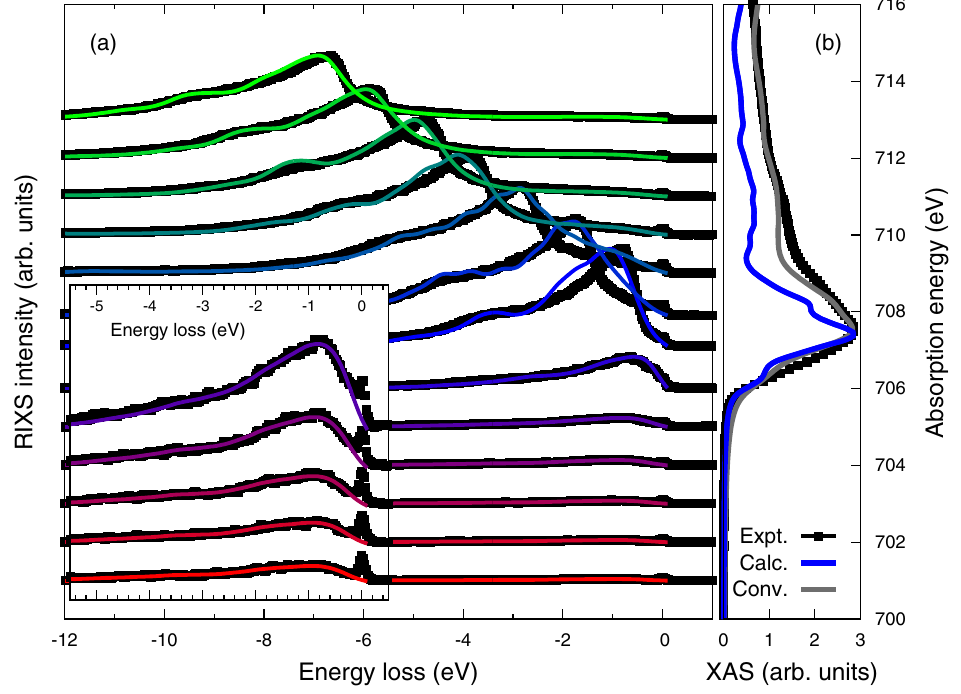
FIG. 4. (a) RIXS spectra at the Fe L 3 edge of BaFe 2 As 2 plotted versus energy loss comparing BSE evaluation of the Kramers- Heisenberg equation (colored curves) to measurement (black symbols). Curves are staggered vertically to align with their corresponding incident photon energies with respect to the Fe L 3 XAS profile shown in (b). The inset in (a) expands the first 5 eVof energy loss for the RIXS profiles with lowest incident photon energies. The momentum transfer for all spectra, experimental and calculated, is (0.31, 0.31, 0) in reciprocal lattice units. Calculated loss profiles correspond to the evaluation of Eq. (8) using an intermediate-state core-hole lifetime equivalent to 0.2 eV HWHM and a final-state broadening of 0.36 eV HWHM. (b) Measured (black symbols) and BSE- calculated (blue curve) XAS at the Fe L 3 edge. The gray curve shows the BSE-calculated spectrum after convolution with a Doniach- Sunjic line shape and corresponds to the red curve in Fig.